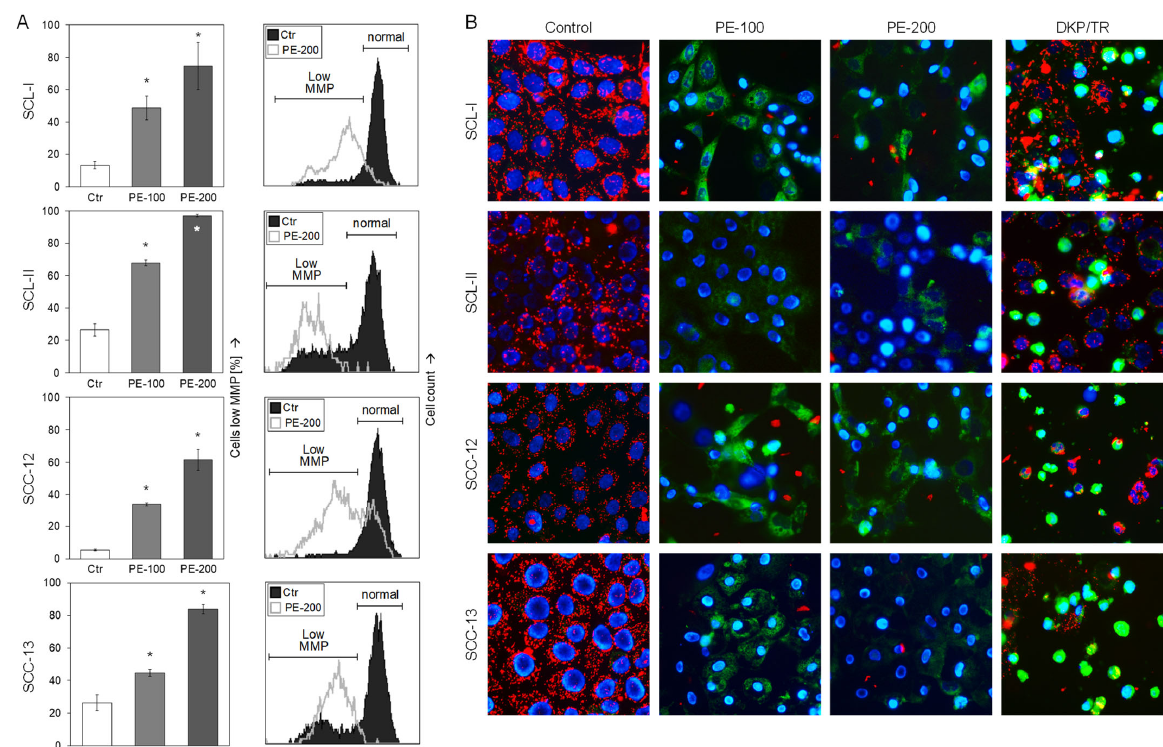
Figure 3. Loss of mitochondrial membrane potential. ( A ) SCL ‐ I, SCL ‐ II, SCC ‐ 12, and SCC ‐ 13 were seeded in 24 ‐ well pates and were treated with PE (100, 200 μ g/mL) for 24 h. Mitochondrial mem ‐ brane potential (MMP) was determined at 24 h by TMRM + staining and flow cytometry. Values represent the percentage of cells with low MMP. Right, examples of flow cytometry reading are shown for 200 μ g/mL treatment (overlays of treated cells vs. Ctr). Cell populations with low and normal MMP are indicated. One of two independent experiments is shown; each individual exper ‐ iment consisted of triplicate values. Statistical significance was calculated from all individual values (#6) and is indicated by asterisks ( p < 0.05, as compared to Ctr). ( B ) Cells were treated with PE ‐ 100 and PE ‐ 200 as well as with DKP ‐ 071 (10 μ M)in combination with TRAIL (DKP/TR, positive control). For microscopic visualization of low MMP, cells were stained with JC ‐ 1 and counterstained with Hoechst ‐ 33342 at 24 h of treatment. Blue, nuclear staining; red, mitochondria with high (normal) MMP; faint green, JC ‐ 1 ‐ stained cytosol; bright green or turquoise, rounded and detached cells. 3.4. Caspase Activation and Upregulation of p21 To identify protein factors that may mediate apoptosis induction as well as inhibition of cell proliferation and cell viability by PE, the cell cycle inhibitors p19 and p21, the main effector caspase ‐ 3 as well as proapoptotic initiator caspases ( − 8 and − 9) were investigated by Western blotting (Figure 4). Some induction of caspase ‐ 3 processing was seen in re ‐ sponse to PE treatment (characteristic cleavage products of 18 and 16 kDa), indicative of caspase ‐ 3 activation. However, this remained on a relatively low level, as seen in compar ‐ ison with a positive control consisting of SCC ‐ 12 cells treated with the indirubin derivative DKP ‐ 071 in combination with TRAIL [24]. Semi ‐ quantitative analyses revealed induction factors of 3x − 4x for the active p16 caspase ‐ 3 cleavage product after PE treatment, while p16 was induced > 60 ‐ fold in the positive control. Similarly, only weak activation was seen for initiator caspases of the proapoptotic extrinsic and intrinsic pathways. Thus, caspase ‐ 8 proform was downregulated to 64% in SCL ‐ II by 200 mg/mL PE, and caspase ‐ 9 cleavage products (35/37 kDa) were slightly upregulated by 200 μ g/mL PE in SCL ‐ I (1.7x) and in